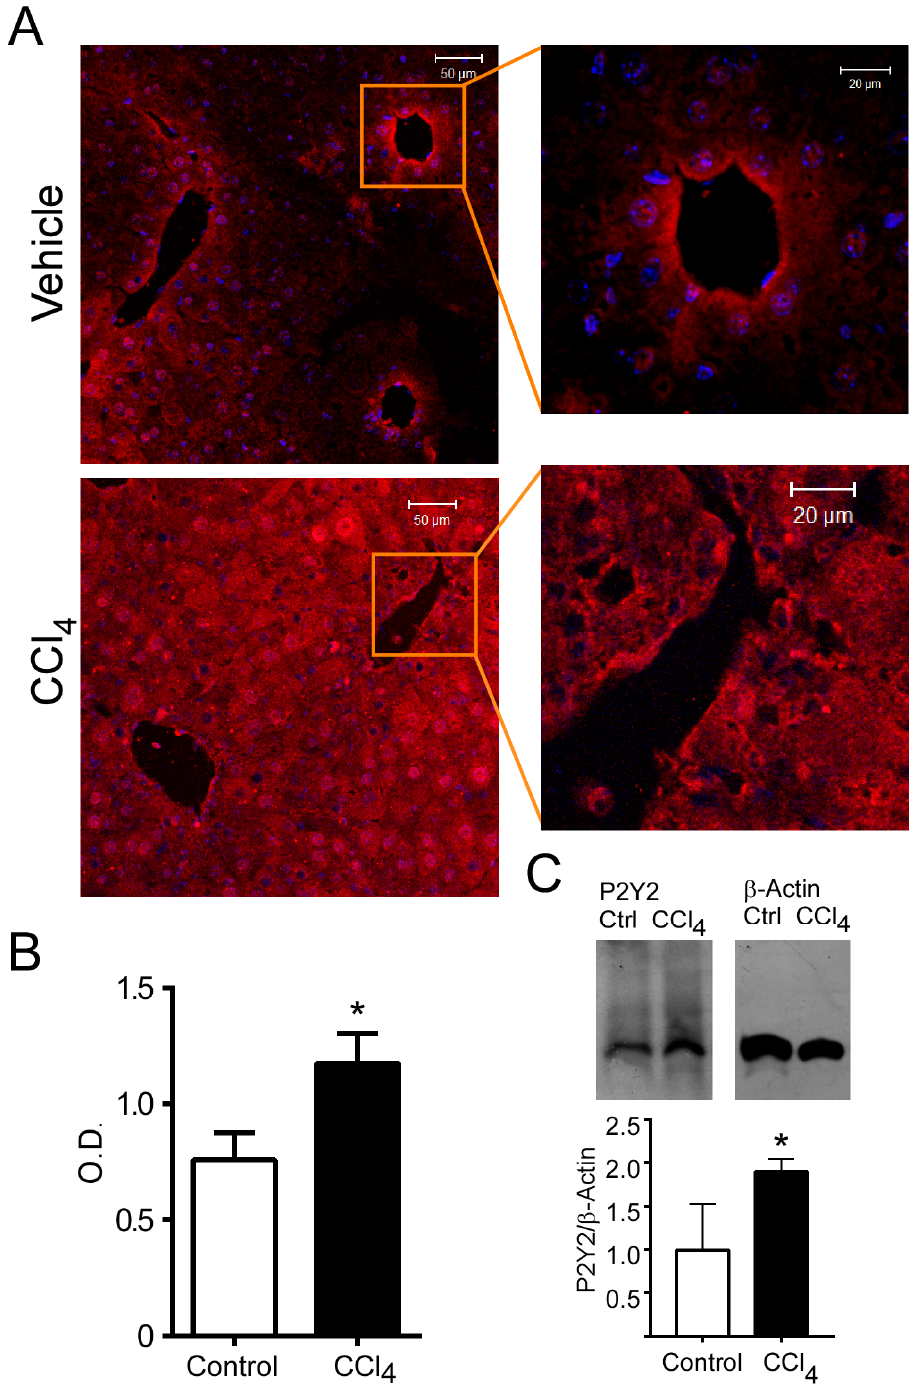
Figure 3. Detection of P2Y2R in liver sections from control and CCl 4 -treated mice. ( A ) Liver slices (5 µm) from vehicle- and CCl 4 -injected mice were labelled by immunofluorescence using a primary antibody directed against the carboxy end of the receptor and a secondary antibody coupled to Cy3 (red signal). ( B ) Total fluorescence was quantified, n = three mice, three slides each, in ( C ) the expression level of P2Y2R was analyzed in samples from control and CCl 4 -treated hepatocytes by Western blot and corrected against β-actin as constitutive protein, * p < 0.05 Student’s t-test . n = 3.